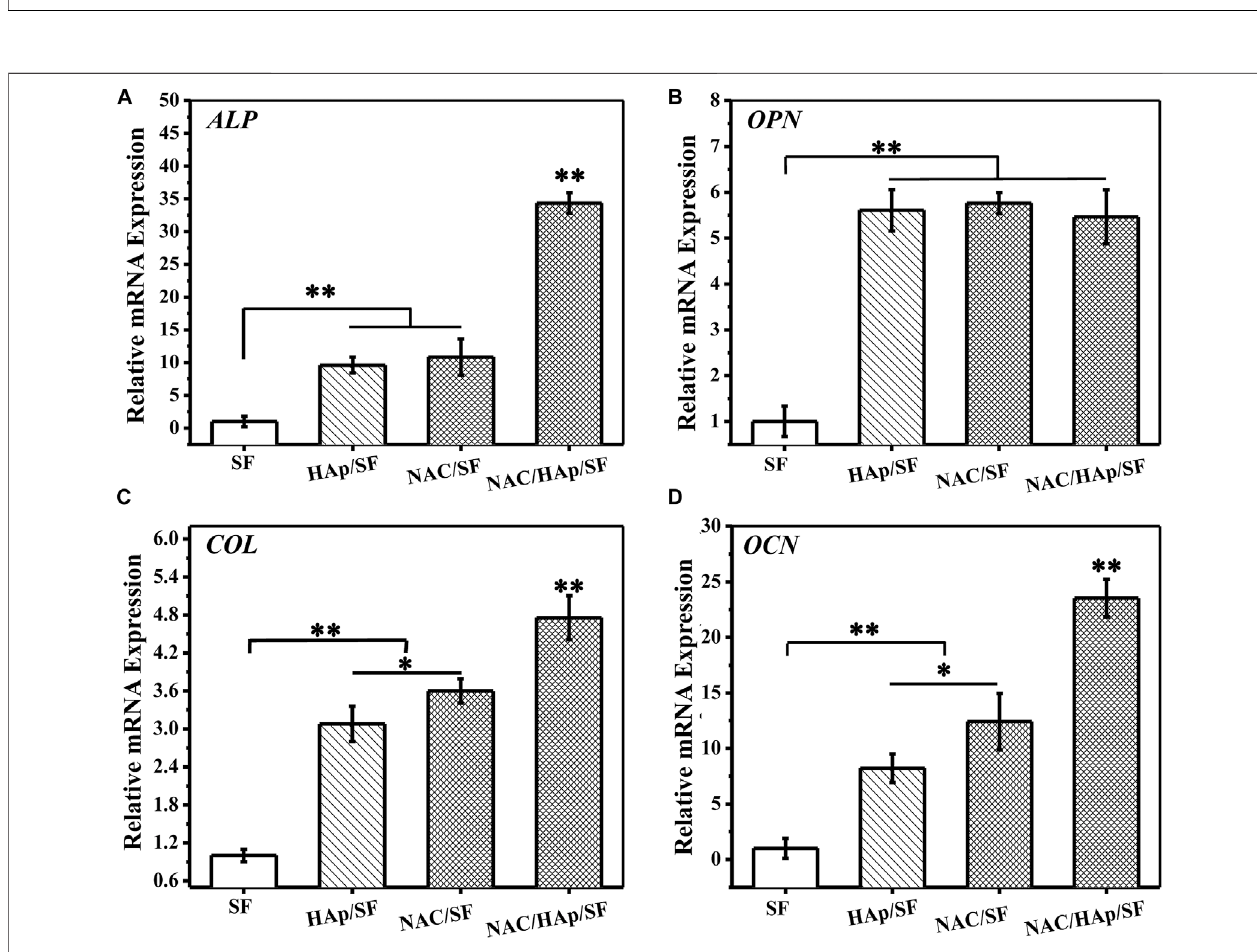
FIGURE 7 | Expressions of bone-related genes in iPSC-MSCs on different nano fi bers for 14 days, n (cid:1) 3.